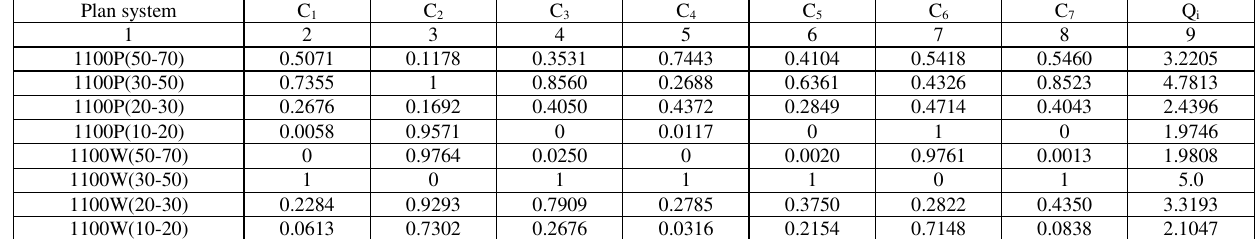
Table 5. Normalized values of diagnostic variables and value of the synthetic variable for HC